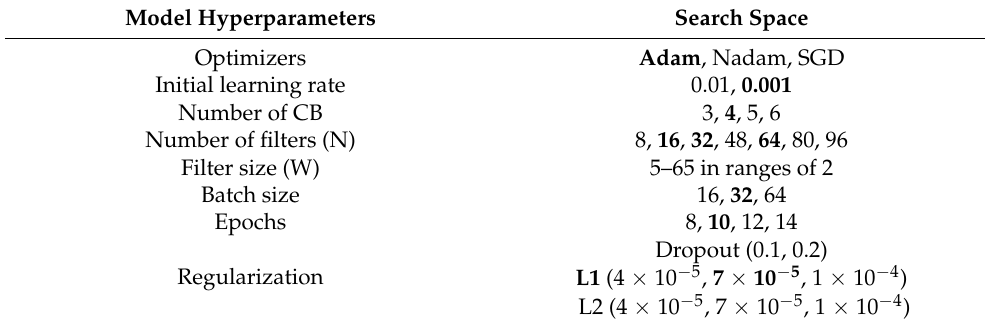
Table 1. Hyperparameter tuning search